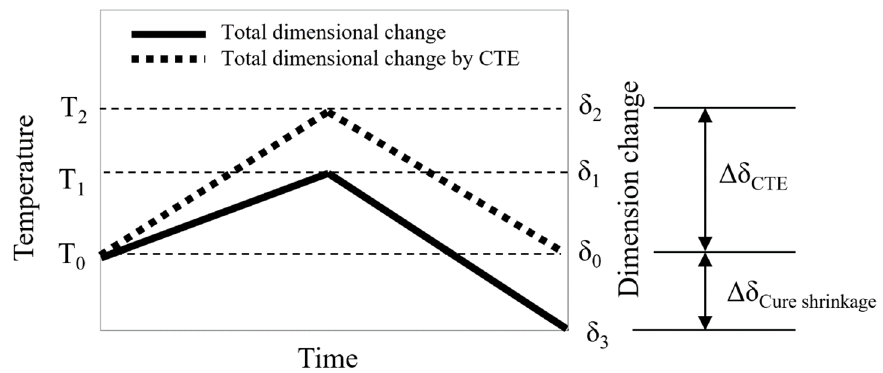
Figure 5. Dimension change by CTE and cure shrinkage.